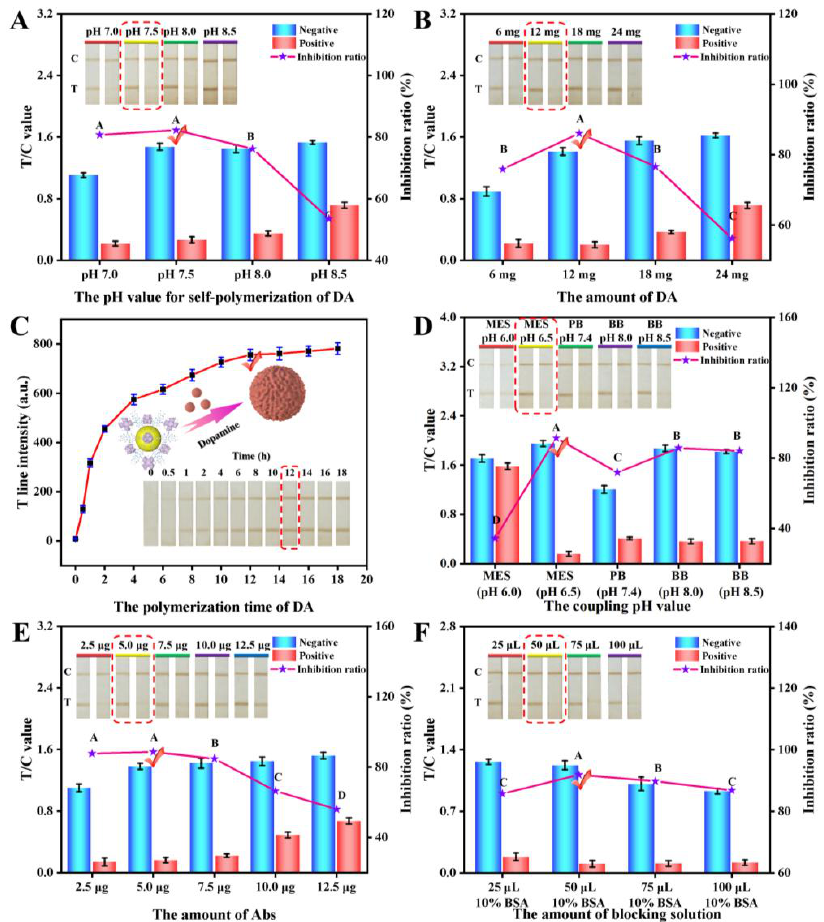
Figure 3. Synthesis optimization of PCN-224@PDA, including ( A ) the effect of the pH value for the self-polymerization of DA, ( B ) the effect of the DA amount, and ( C ) the effect of the polymerization time of DA. Optimization of the key technical parameters of PCN-224@PDA-ICA, including ( D ) the effect of the coupling pH value, ( E ) the effect of the Ab amount, and ( F ) the effect of the amount of blocking solution. The inhibition ratio was obtained through the formula: inhibition ratio (%) = (1 − (T⁄C) positive /(T⁄C) negative ) × 100%. The concentration of GP was fixed at 5 ng/mL (in 0.02 M PB buffer) for positive results. Different letters represent statistical differences ( p < 0.01).